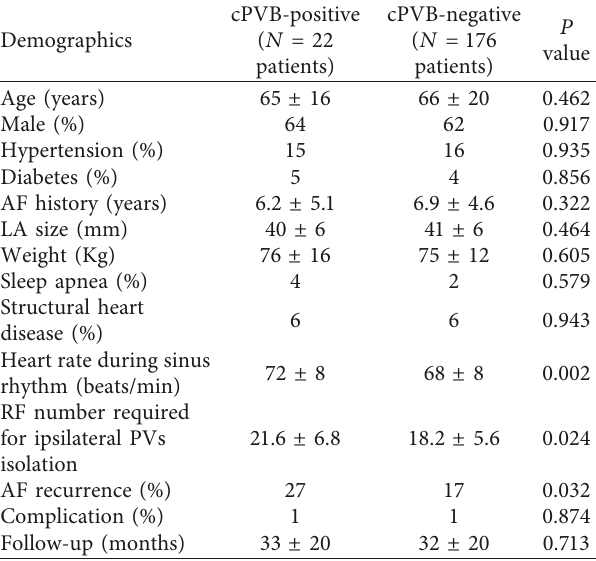
Table 2: Patient demographics and procedural data.